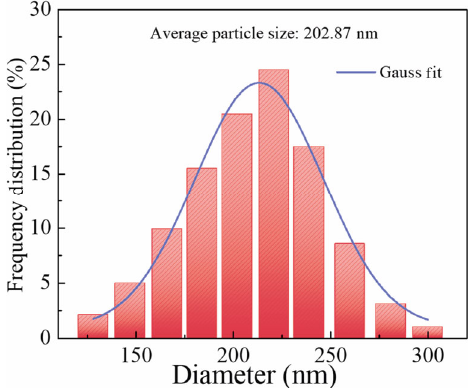
Fig. 7 Particle size distribution of the α-Fe 2 O 3 @SiO 2 pigments with shell thickness of 60 nm.